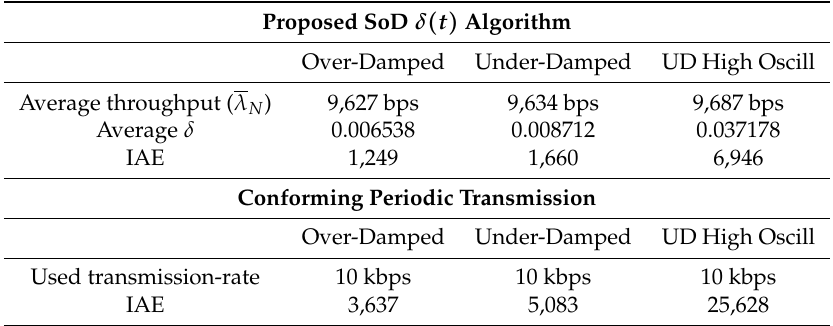
Table 2. Results summary.